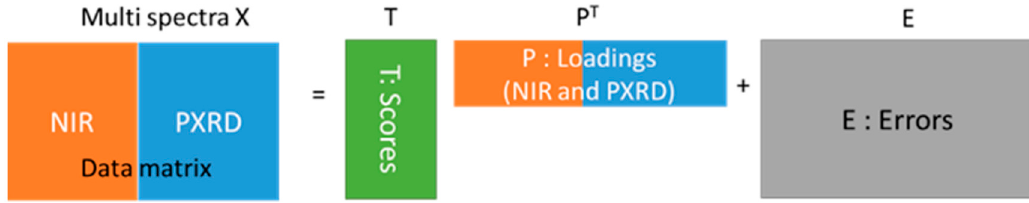
Figure 11. DVS results of bulk materials (left) and prepared samples